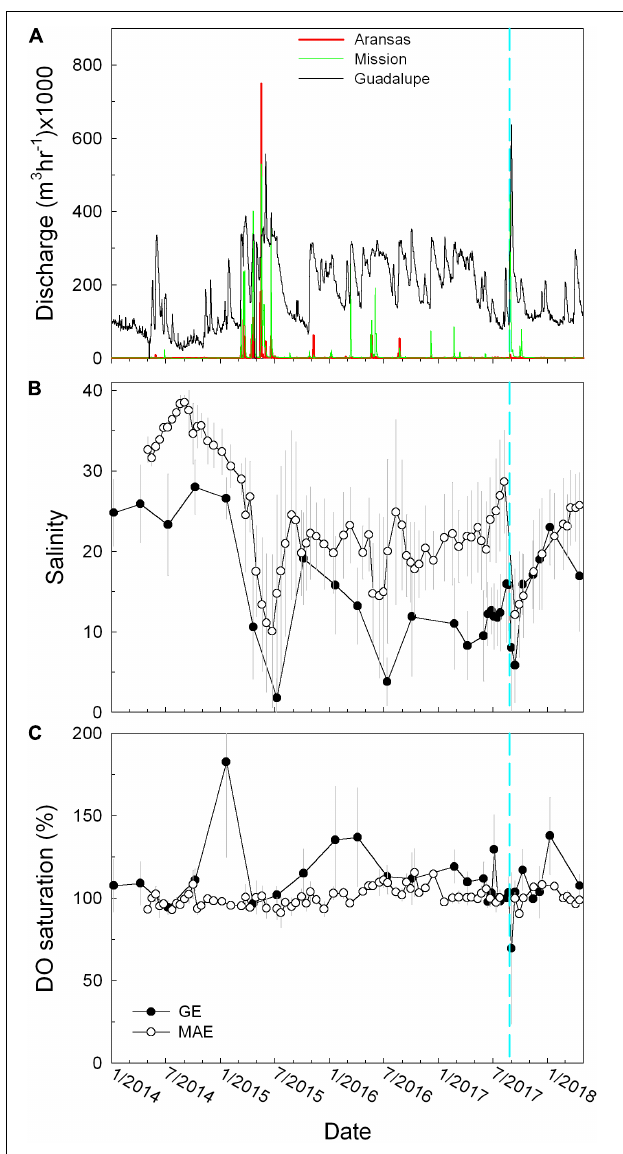
FIGURE 2 | (A) Discharge of Aransas (red), Mission (green), and Guadalupe (black) rivers. (B) Average salinity in MAE (open circles) and GE (closed circles). (C) Percent saturation of dissolved oxygen. The gray vertical lines represent standard deviation of the mean. The cyan dashed lines (and in figures hereafter) represent the date (August 25, 2017) on which Hurricane Harvey made